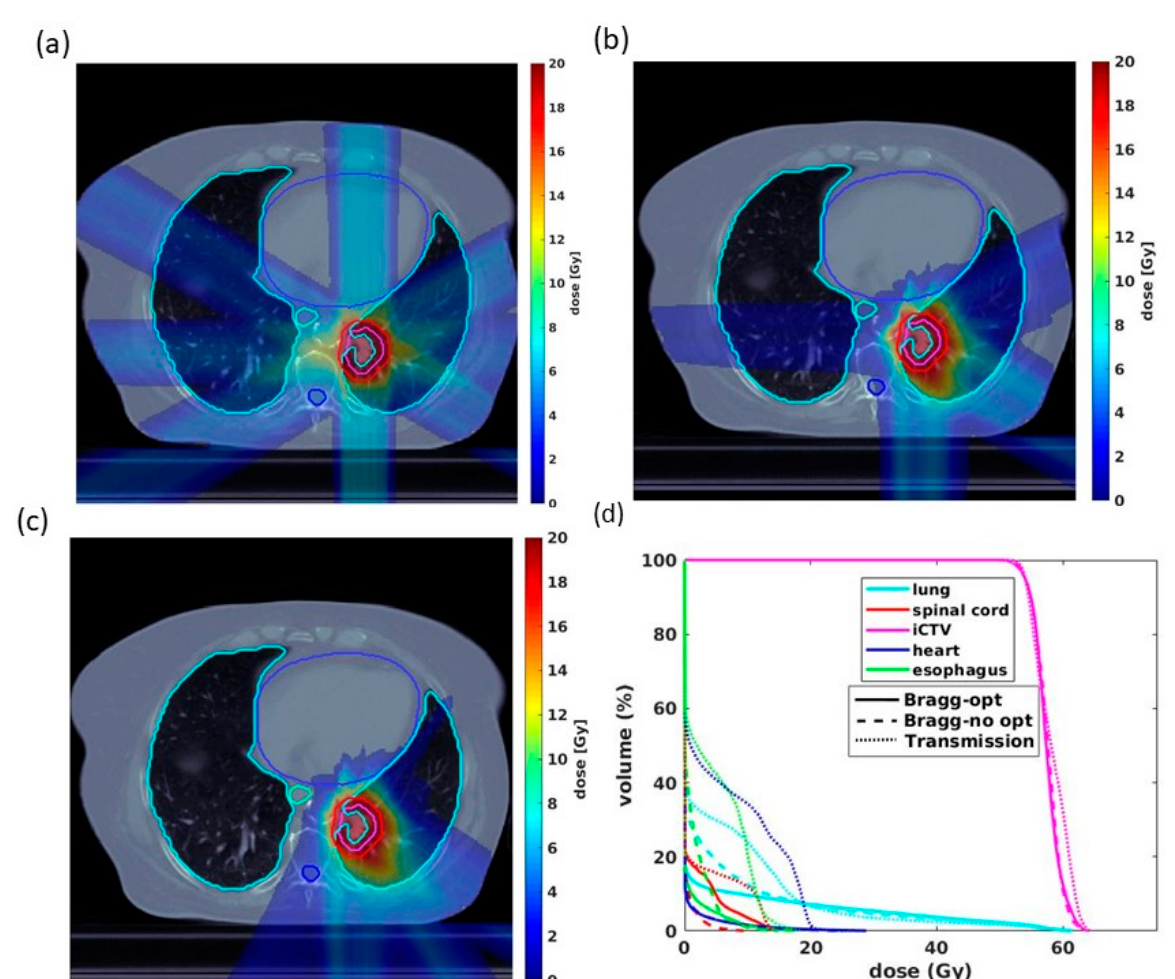
Figure 1. Dosimetry comparison between transmission and Bragg peak proton FLASH plans for one representative case. ( a ) Transmission plans with 4 beam angles with each angle separation. ( b ) Bragg peak plans with the same arrangement as transmission plans. ( c ) Bragg peak plans with an optimized beam angle arrangement better approximating current conventional-dose rate PBS plans used in clinical practice. ( d ) DVHs of the three plans, demonstrating differences in OARs and target dose coverage.